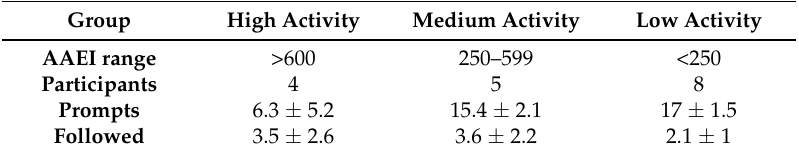
Table 4. Three groups of exercise performance.